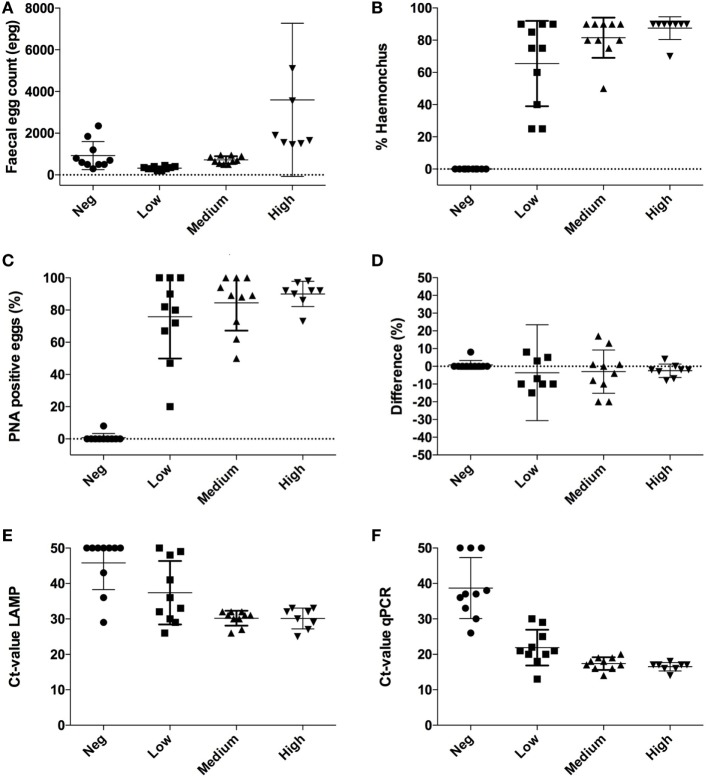
Individual results obtained with four different diagnostic methods applied to subsamples of fresh feces from 38 sheep. Samples were divided into four groups with samples from 8 to 10 sheep based on their nematode fecal egg count (FEC) and presence or absence of H. contortus following McMaster examination. (A) FEC expressed as eggs per gram feces (epg). Note one extreme value in the group “High” with 12,100 epg is outside the graph; (B) proportion of eggs identified as H. contortus in the McMaster chamber, (C) proportions of eggs in the samples that were stained with peanut agglutinin (PNA); (D) comparison between H. contortus-positive eggs with McMaster and following the PNA test; (E) cycle threshold (Ct) values with real-time quantitative polymerase chain reaction (qPCR); (F) Ct values with loop-mediated isothermal amplification (LAMP). For graphical reasons, negative results in both molecular tests are replaced with a Ct value of 50.